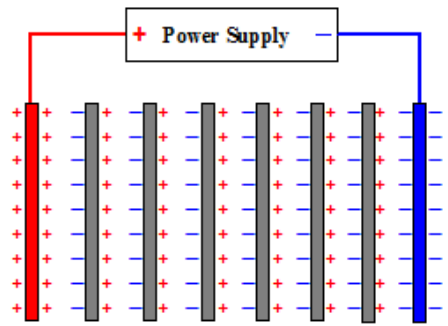
Figure 3. Electrode's polarity in a bipolar system.